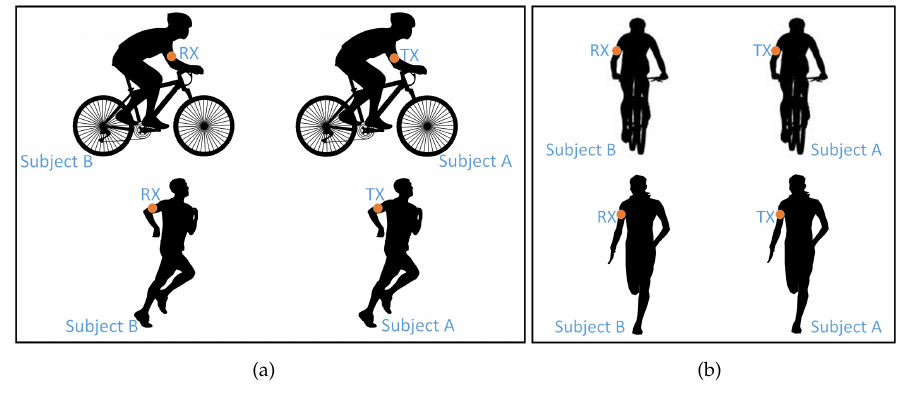
Figure 2. Investigated scenarios of the BBWN measurement campaign. Activities involved were running and cycling. ( a ) Scenario 1, subject behind the other; ( b ) Scenario 2, subject beside the other. The nodes are attached to the side of the upper arms with a radiation pattern away from the